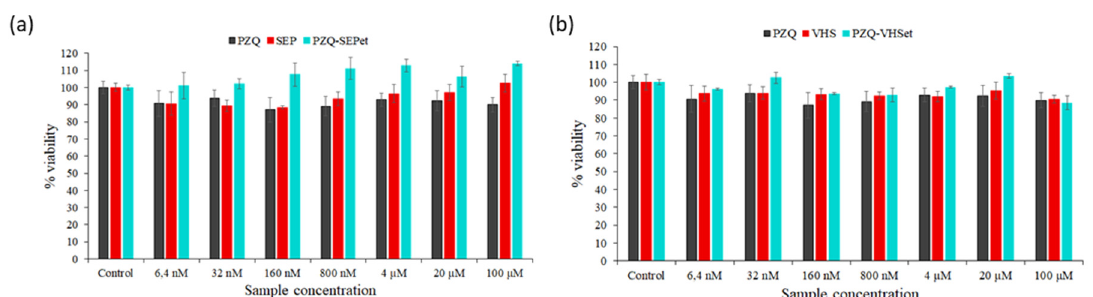
Figure 6. Cell viability of SEP and PZQ–SEPet ( a ), and VHS and PZQ–VHSet ( b ) compared to PZQ after 48 h of treatment. (Control: untreated cells in complete medium; mean values ± 8 SE; n = 3).